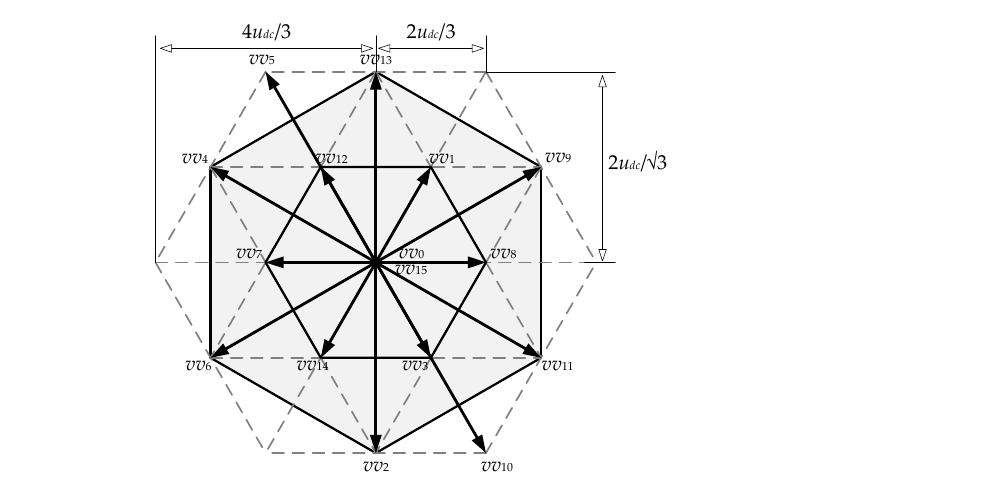
Figure 5. Voltage vector distribution of a three-phase series-winding PMSM in α - β subspace.